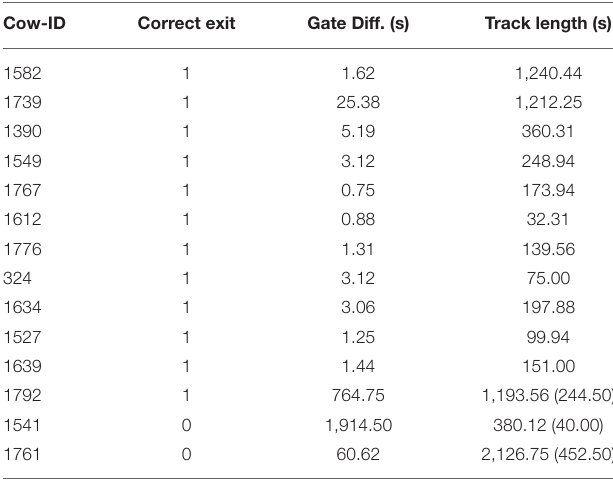
TABLE 2 | Complete trajectories of the crowded sequence with columns indicating: cow id-number, tracker found the correct exit gate, time-difference between tracker exit and exit registered by the gate in seconds and the total length of the track in seconds. Cow-ID